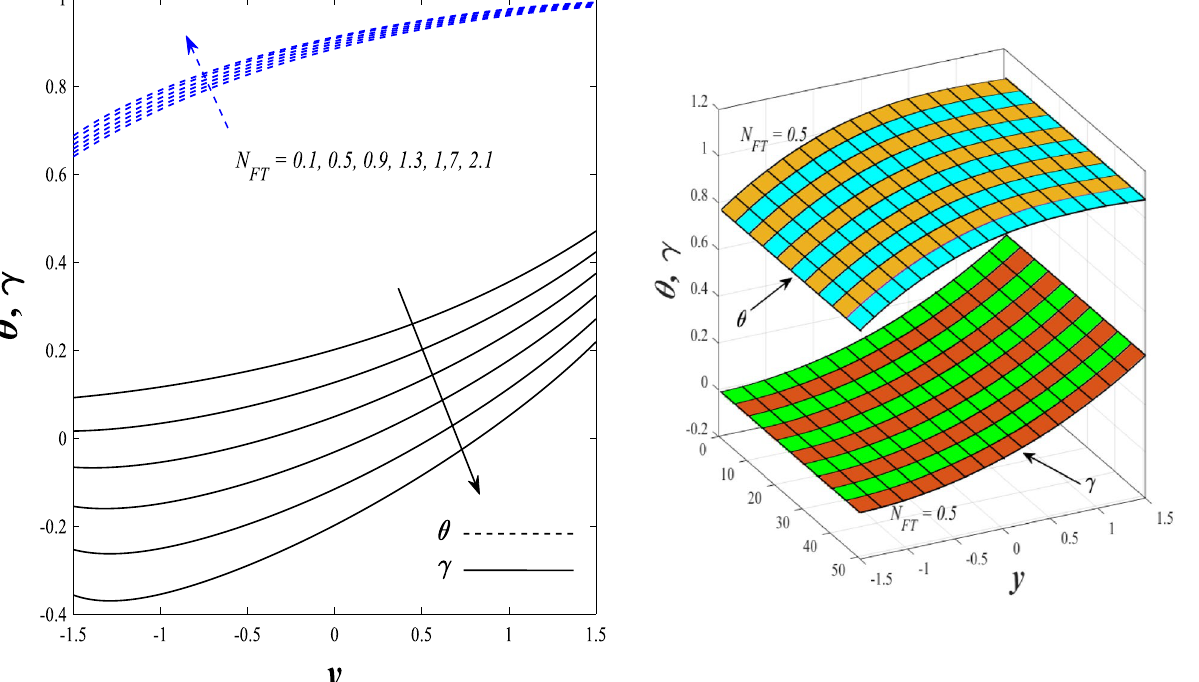
Figure 20. Effect of Soret parameter N F T on the distributions of both temperature and solutal concentration 2D and